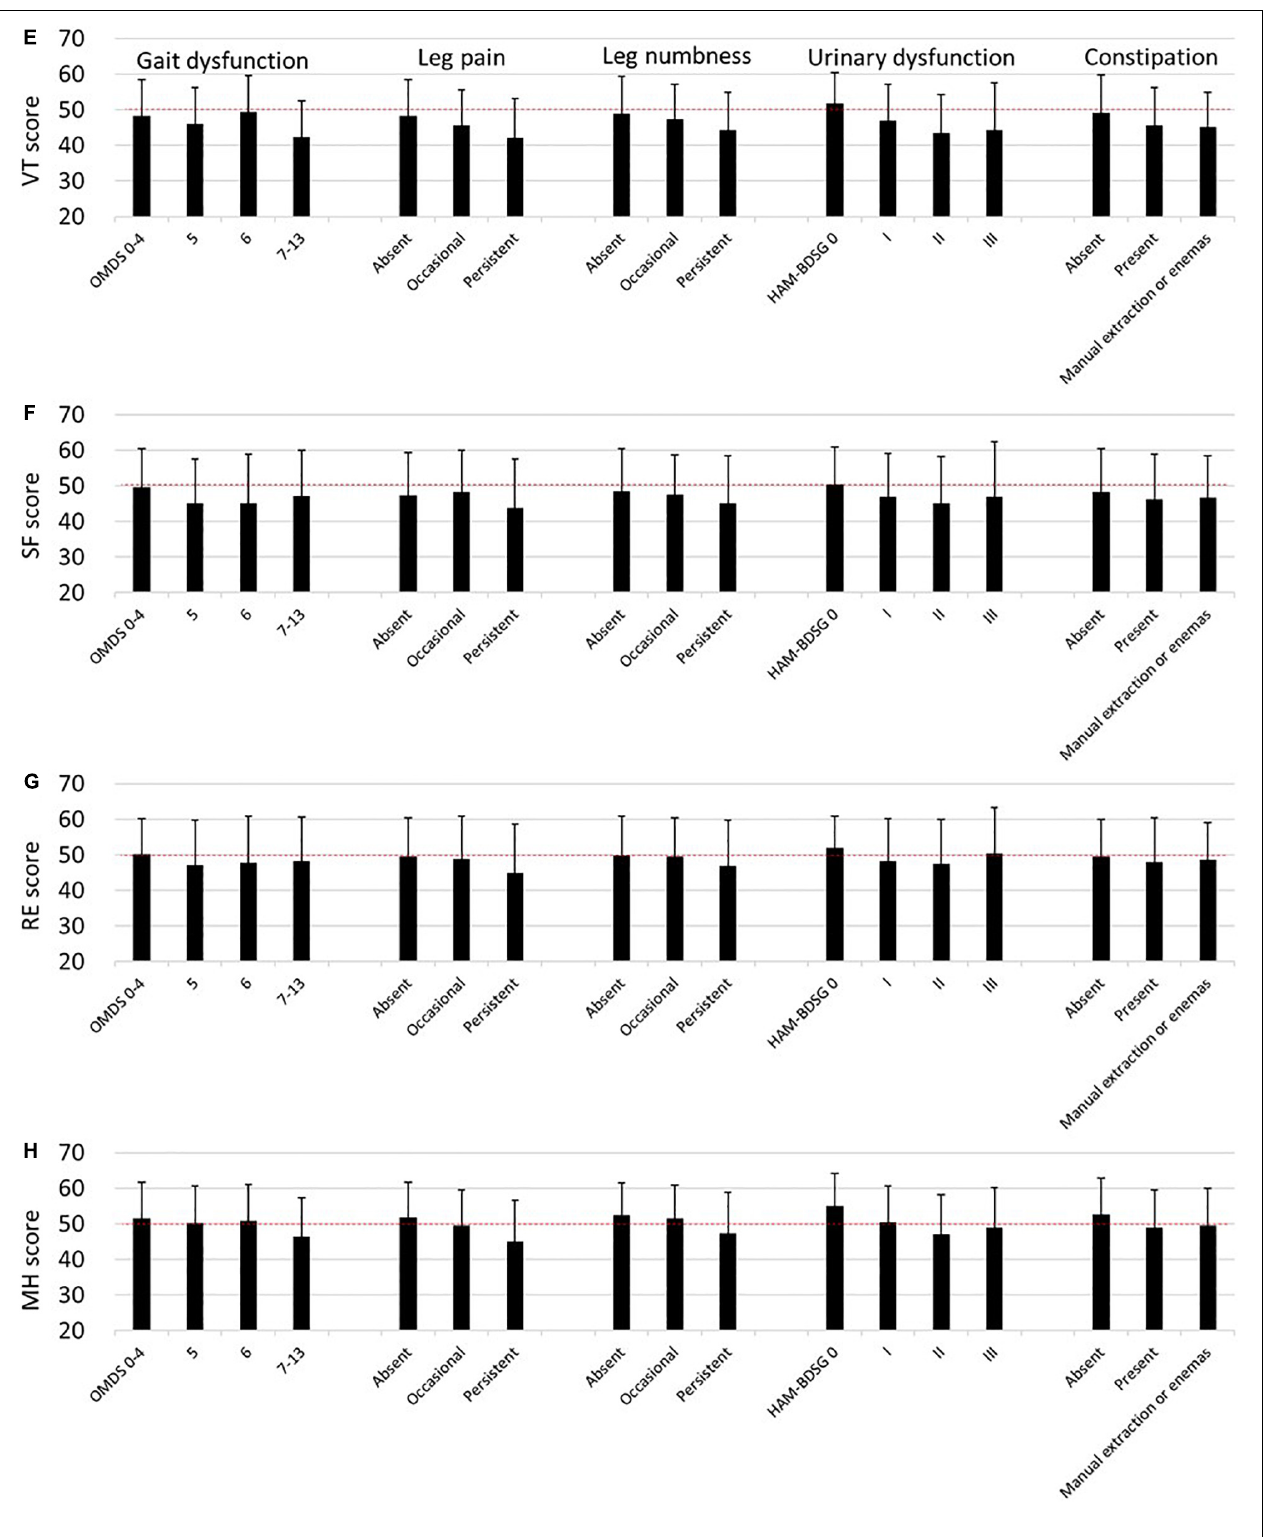
FIGURE 4 | SF-36 subscales according to HAM-related symptoms. The SF-36 subscale scores are expressed as means and standard deviations ( n = 538). The dashed lines (50 points) indicate the mean score of the SF-36 subscales among the general Japanese population. (A) Physical functioning (PF), (B) role physical (RP), (C) bodily pain (BP), (D) general health perception (GH), (E) vitality (VT), (F) social functioning (SF), (G) role emotional (RE), (H) mental health (MH). HAM-BDSG, HAM-bladder dysfunction severity grade; OMDS, Osame Motor Disability Score.